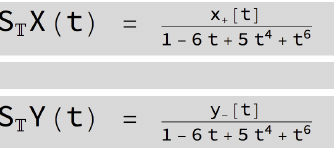
Figure 26. Output given by the [SInt] algorithm.